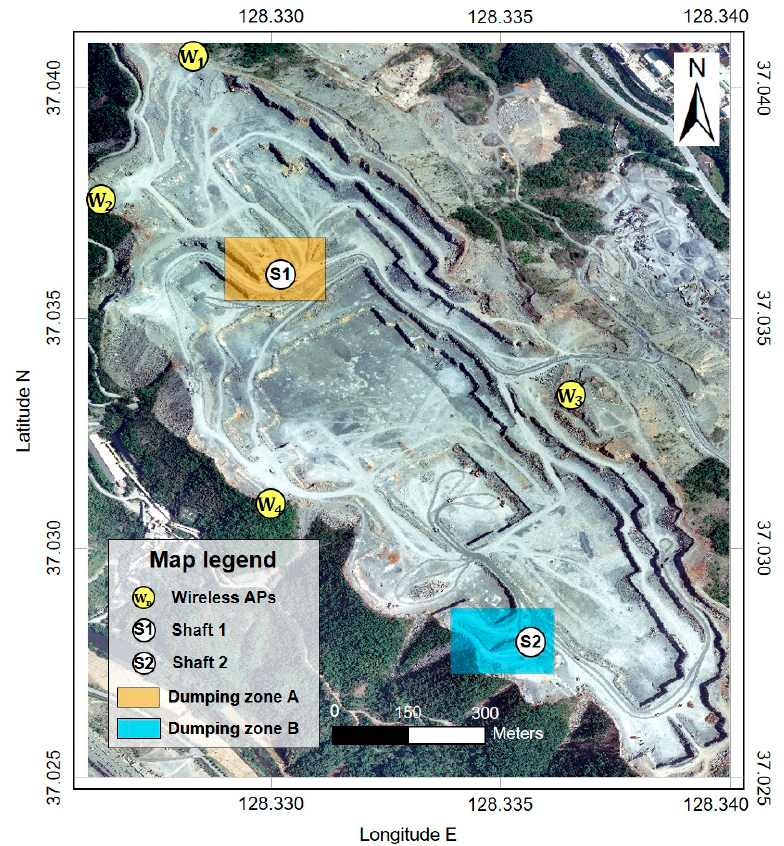
Figure 1. Aerial view of investigation location (image source: National Geographic Information Institute in South Korea, map datum: World Geodetic System (WGS) 1984).